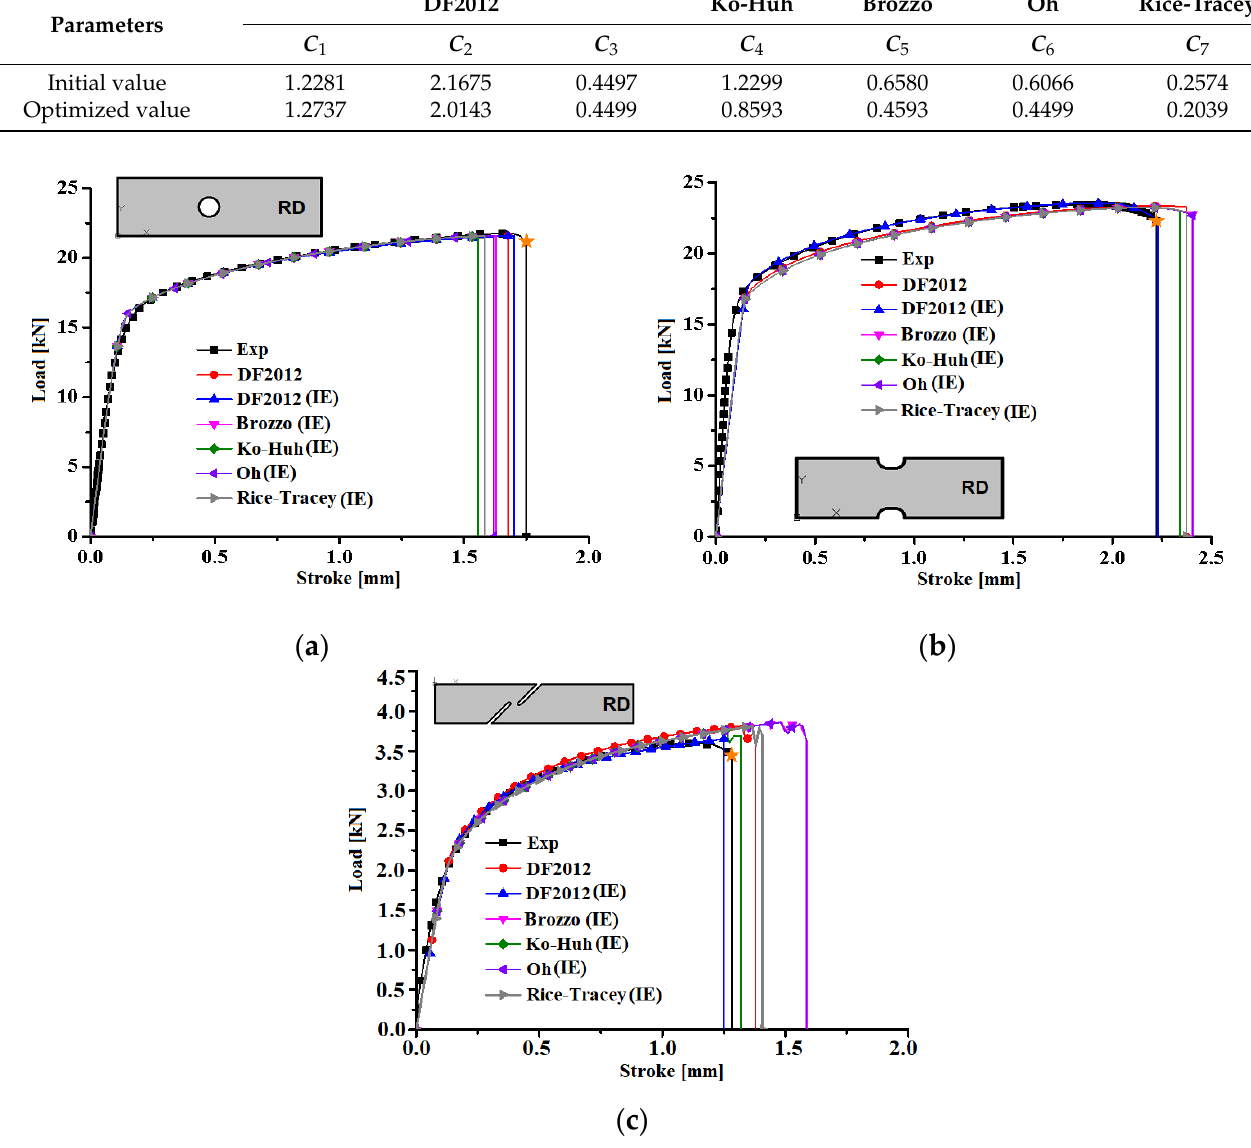
Figure 15. The stroke-load curves predicted by the ductile fracture criteria: ( a ) specimen with a central hole; ( b ) notched specimen; ( c ) in-plane shear specimen.